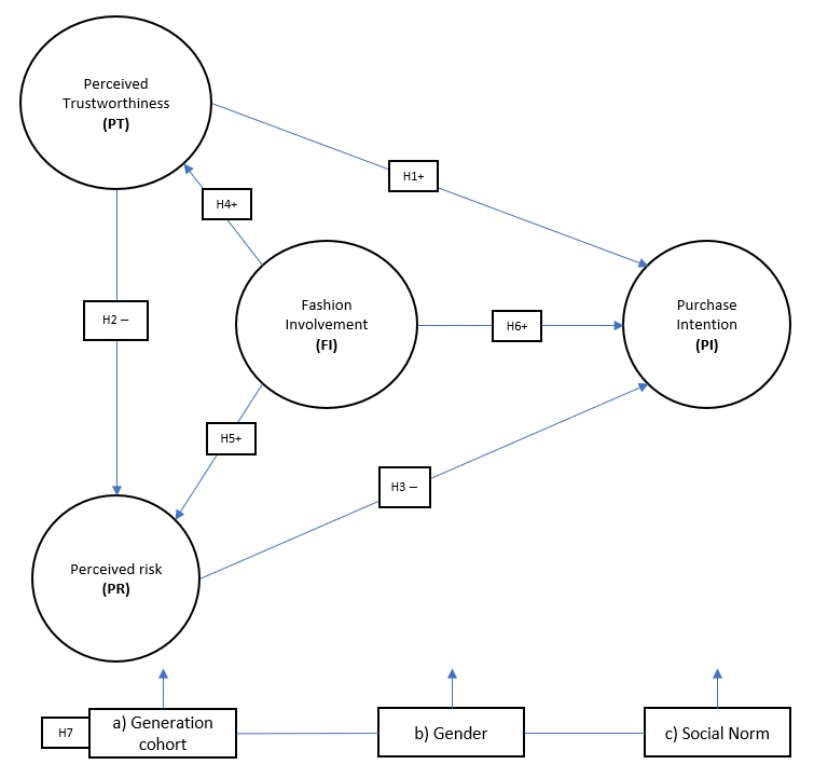
Figure 1. Research Figure 1. Research model.